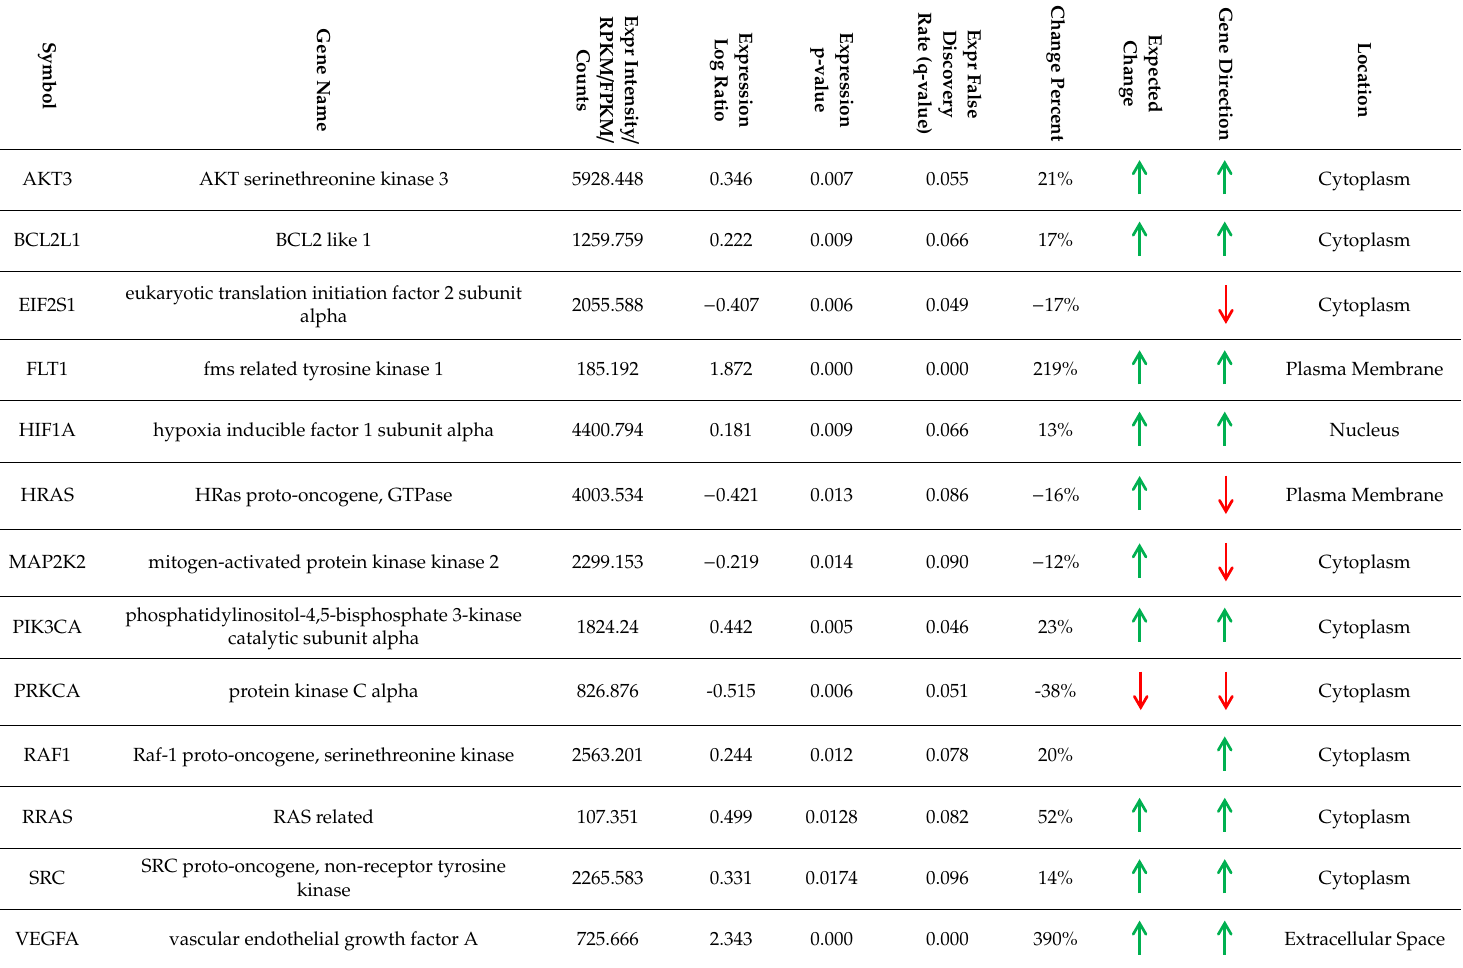
The “expected change” column indicates the state that the gene is predicted to have if the pathway was activated. In the “gene direction” column we can see if the gene is acting as expected, as also seen in the “expression log ratio” column, which represents the Log2 fold change of the gene. Green arrows- upregulation of the gene. Red arrows-downregulation of the